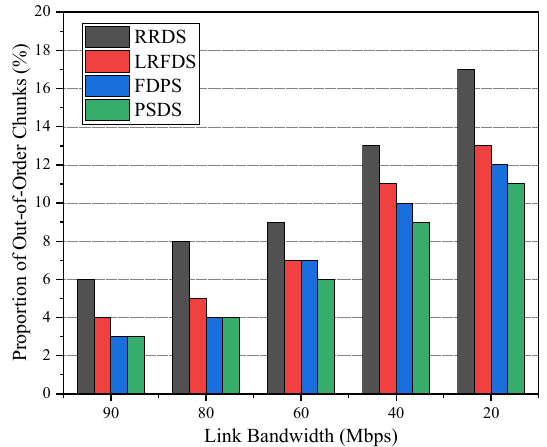
Figure 10. Proportion of out-of-order chunks under different bandwidths.